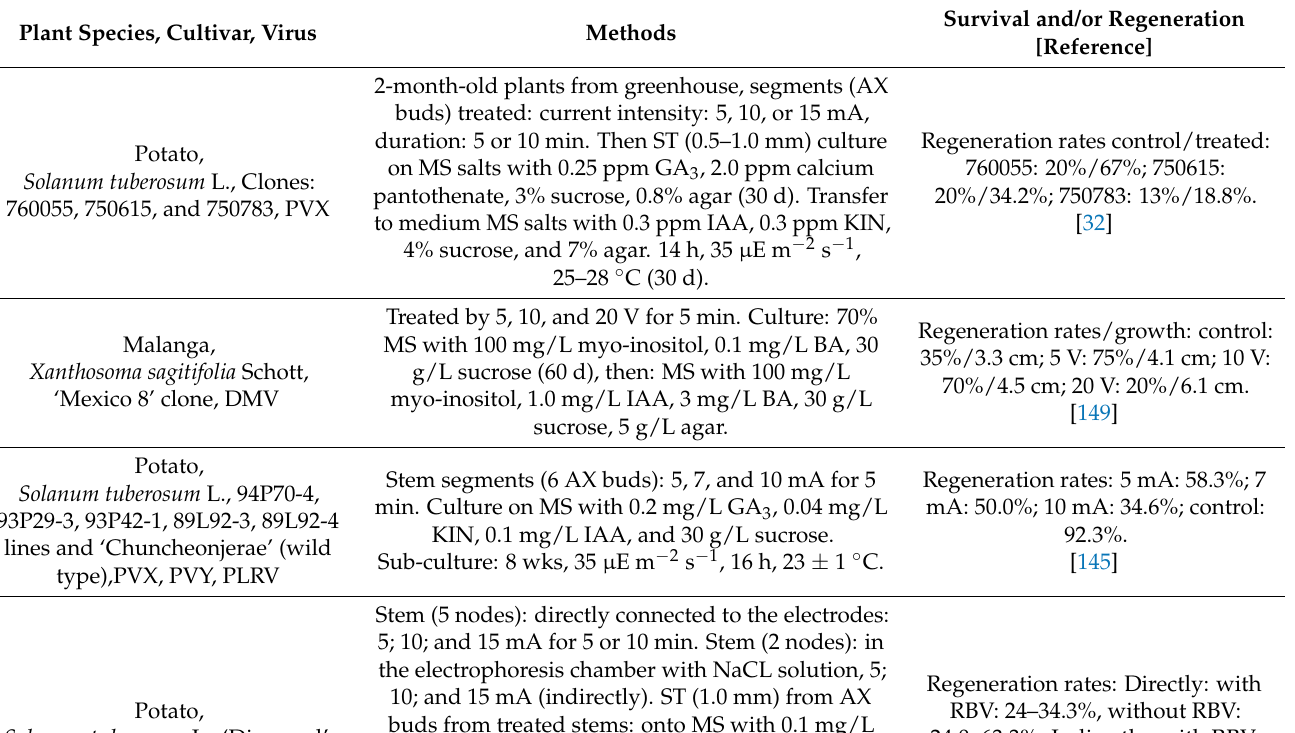
Table 4. Results of virus elimination experiments performed by electric treatment. Plant Species, Cultivar, Virus